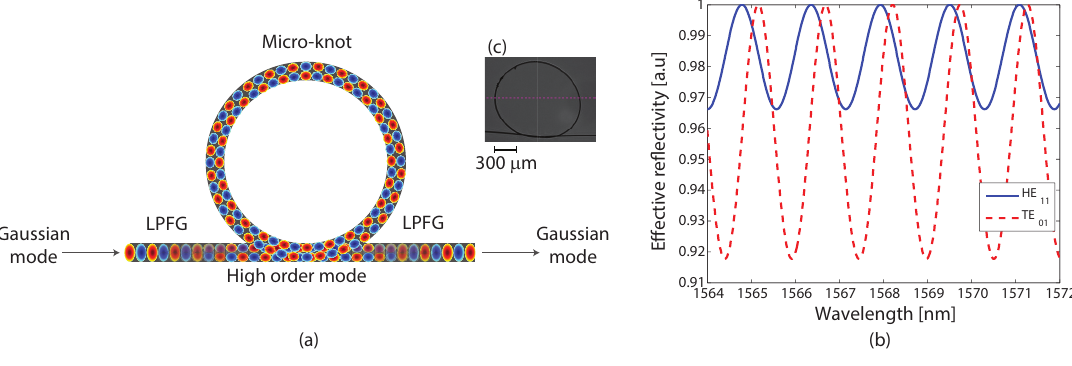
Figure 2. ( a ) Schematics of a micro-knot fabricated from a long-period fiber grating (LPFG). The LPFG excites the input Gaussian mode to a high-order mode that oscillates in the micro-knot and excites back to the Gaussian mode at the output. ( b ) Calculated spectral response of a micro-knot excited by two different modes: Gaussian HE 11 mode denoted by the solid curve and the higher TE 01 mode denoted by the dashed curve. ( c ) A microscope image of a fiber micro-knot fabricated from a